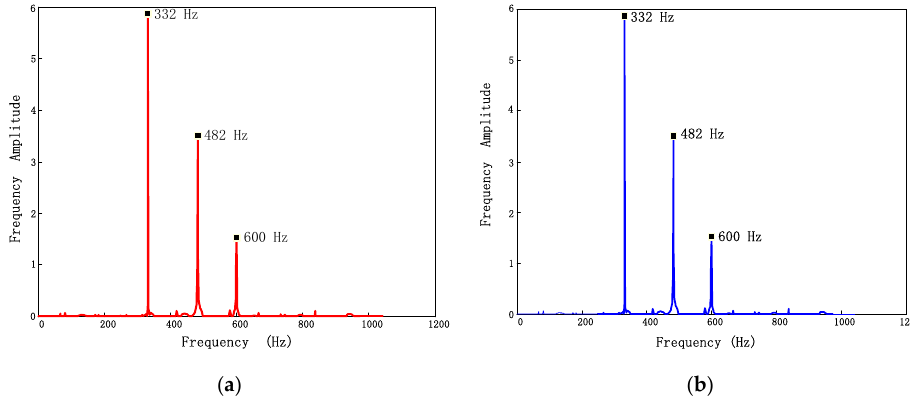
Figure 6. Comparison of frequency recovery of unbiased BTT data ( a ) Frequency spectrum recovered by BP ( b ) Frequency spectrum recovered by BPDN.